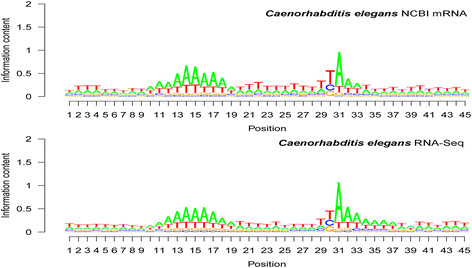
Base composition patterns around polyadenylation [poly(A)] sites: comparison between NCBI mRNA sequences and Illumina TruSeq reads. Note that the poly(A) site and the bases located immediately downstream of it were richer in A in Illumina reads than in NCBI mRNA sequences, suggesting a higher proportion of internal priming and likely also artifact poly(A) tails created by RNA/cDNA fragmentation in the RNA-Seq (TruSeq) reads than in the NCBI mRNA sequences.